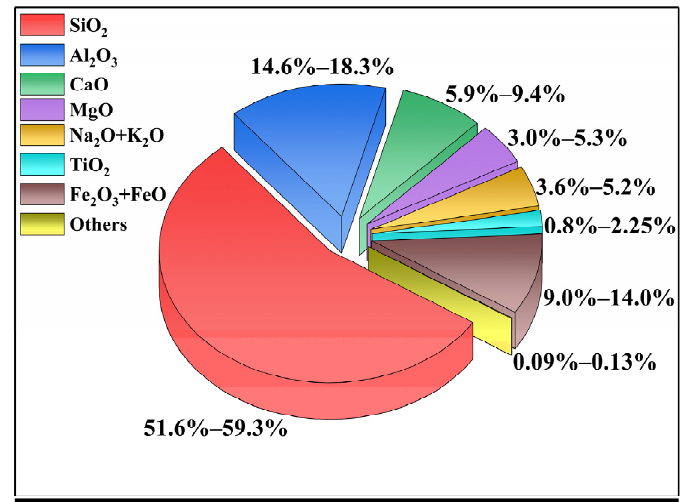
Figure 1. Chemical composition of basalt fiber (BF).